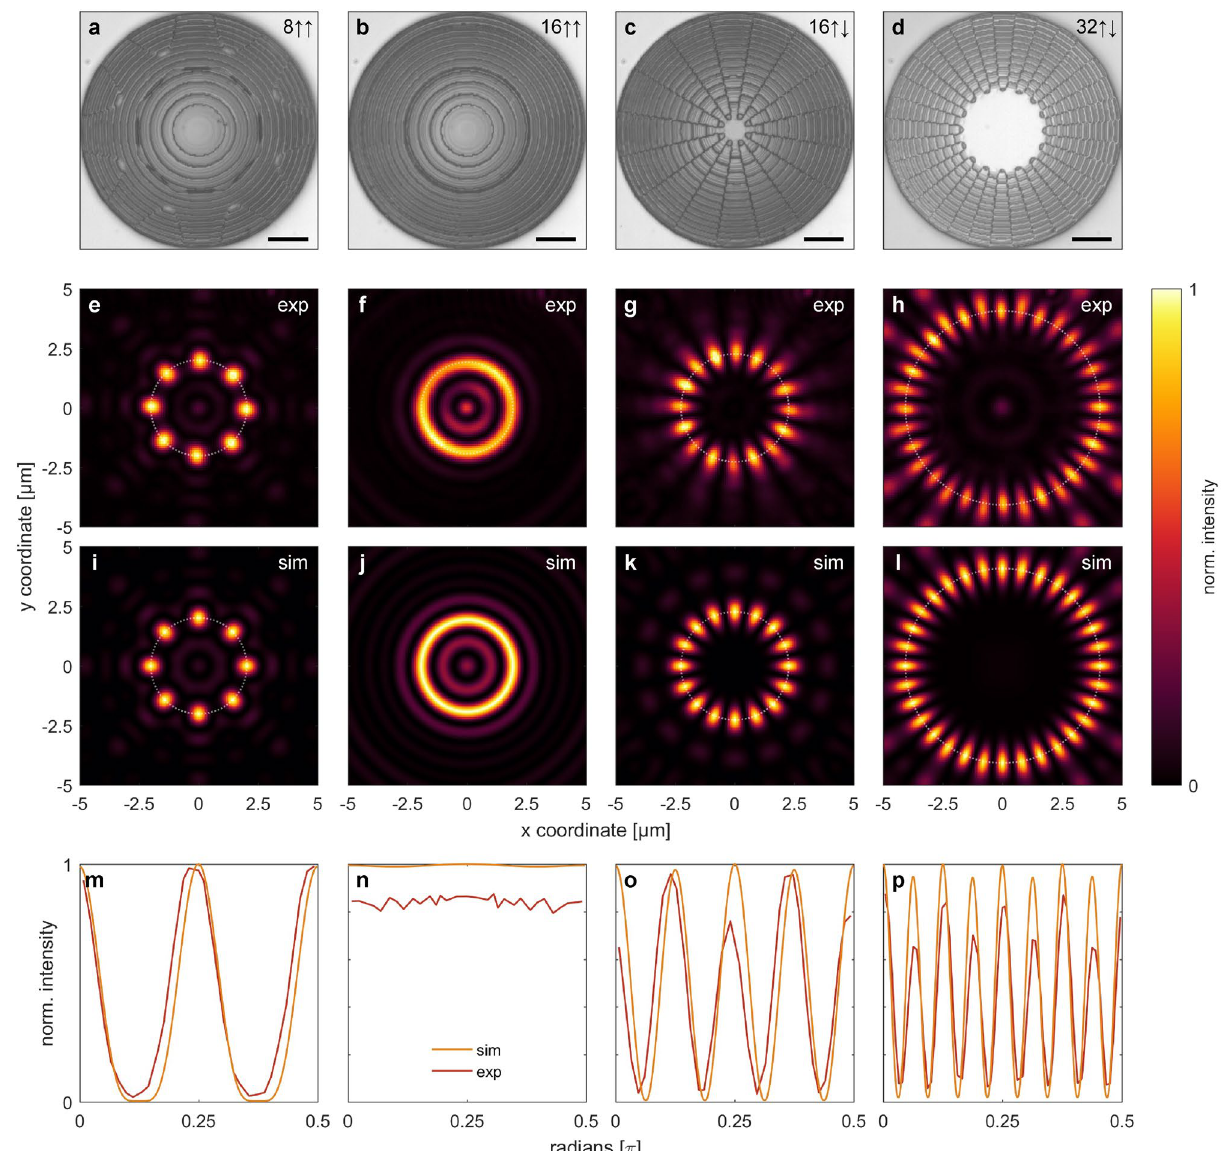
Figure 4. ( a )–( d ) Selected examples of implemented CGHs, ( e )–( h ) measured and ( i )–( l ) simulated intensity distributions in the focal plane for the situation where a discrete number of foci are located on an annulus of circumference C = 16 d min . ( m )–( p ) show the corresponding comparisons of the azimuthal intensity distributions along the white dotted circles. Each column refers to a different configuration (from left to right): ( a ), ( e ), ( i ), ( m ) N = 8 , Λ 1 = 2 d min , ↑↑ ; ( b ), ( f ), ( j ), ( n ) N = 16 , Λ 2 = 4 / 3 d min , ↑↑ ; ( c ), ( g ), ( k ), ( o ) N = 16 , Λ 2 = 4 / 3 d min , ↑↓ ; ( d ), ( h ), ( l ), ( p ) N = 32 , Λ 3 = 2 / 3 d min , ↑↓ . The scale bars in the top row refer to 10